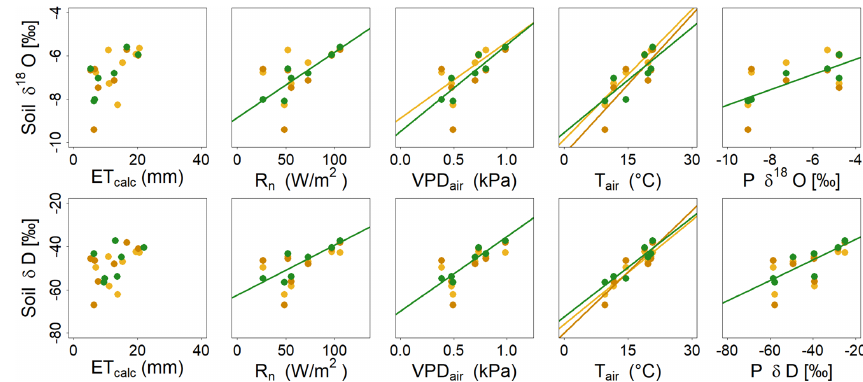
Figure 7. Linear correlations at the grassland (yellow), shrub (orange) and tree sites (green) between mean analysed soil water isotopic composition on the individual sampling dates and mean values of environmental parameters in the month before or weeks between the respective samplings. Table 7. Correlations between analysed soil water isotopic composition and mean environmental variables ∼ 4 weeks prior to the sampling (Fig. 7). ET calc T air VPD air R n P isotopes R 2 p value R 2 p value R 2 p value R 2 p value R 2 p